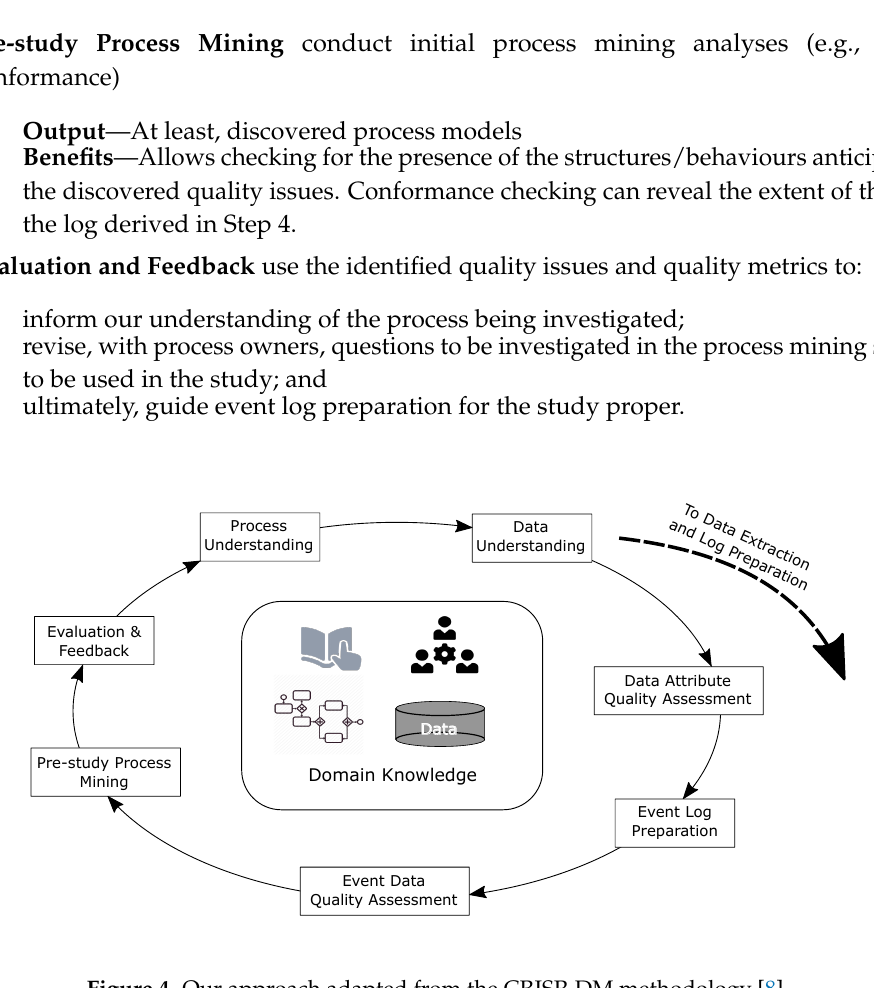
Figure 4. Our approach adapted from the CRISP-DM methodology